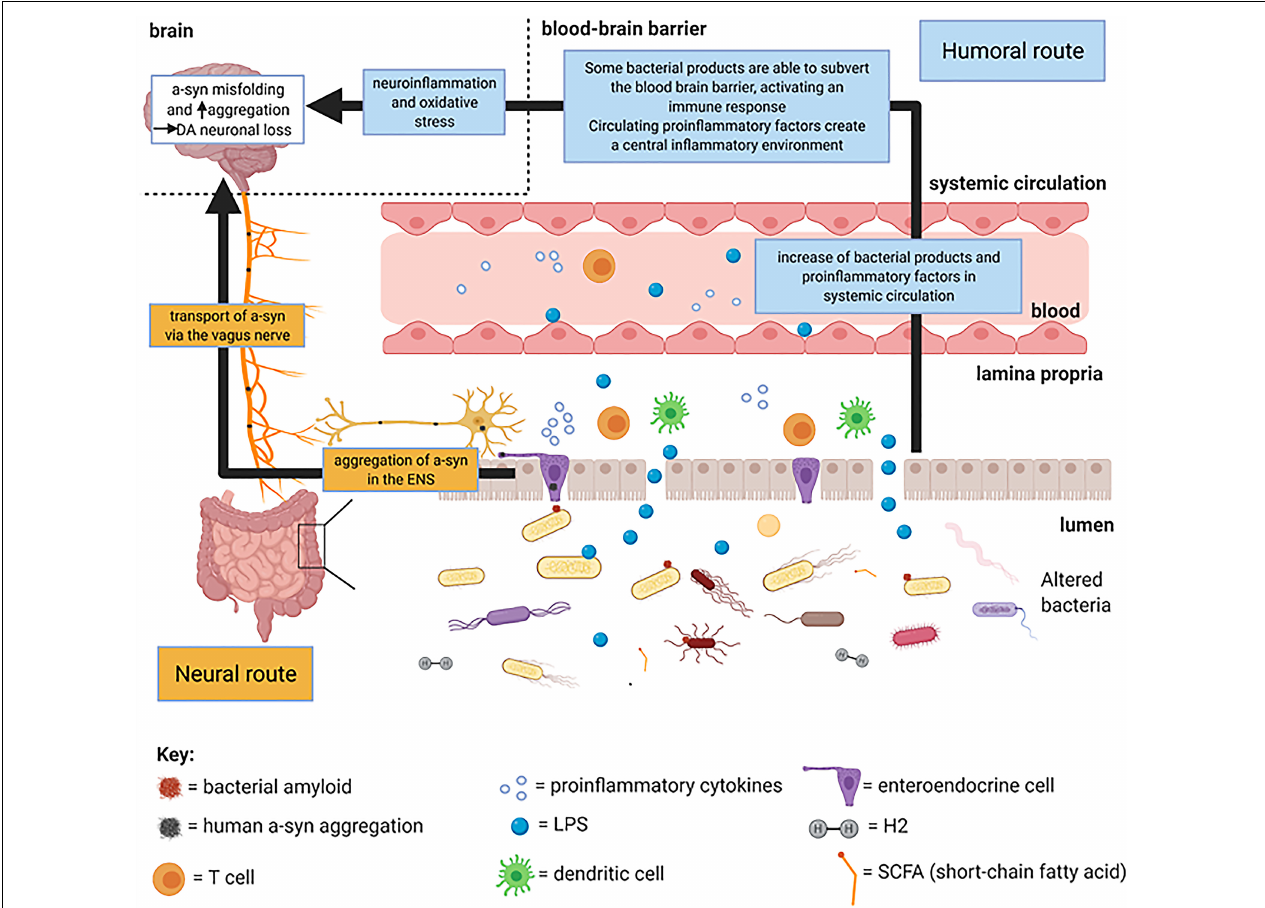
FIGURE 1 | Summary diagram of the main mechanisms by which gut microbiota dysbiosis (specifically of bacteria) may cause PD pathophysiology. Created with BioRender.com.